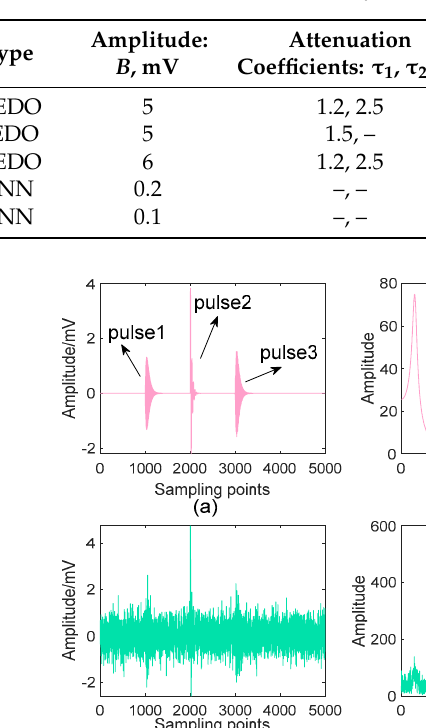
Table 1. Parameters of the synthetic UHF PD signal.